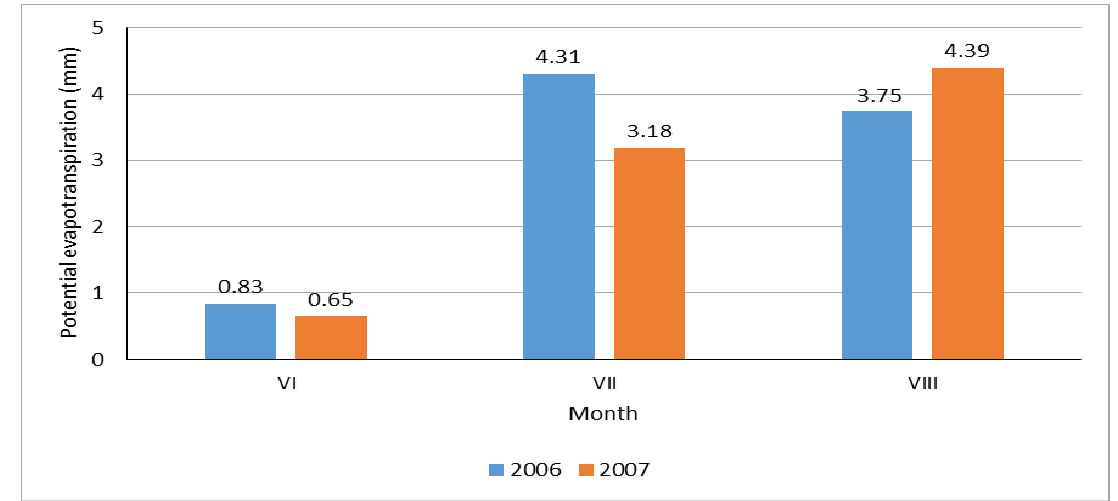
Figure 2. Daily values of the potential evapotranspiration (mm) of the asparagus plants under drip irrigation conditions in particular months of the irrigation period.